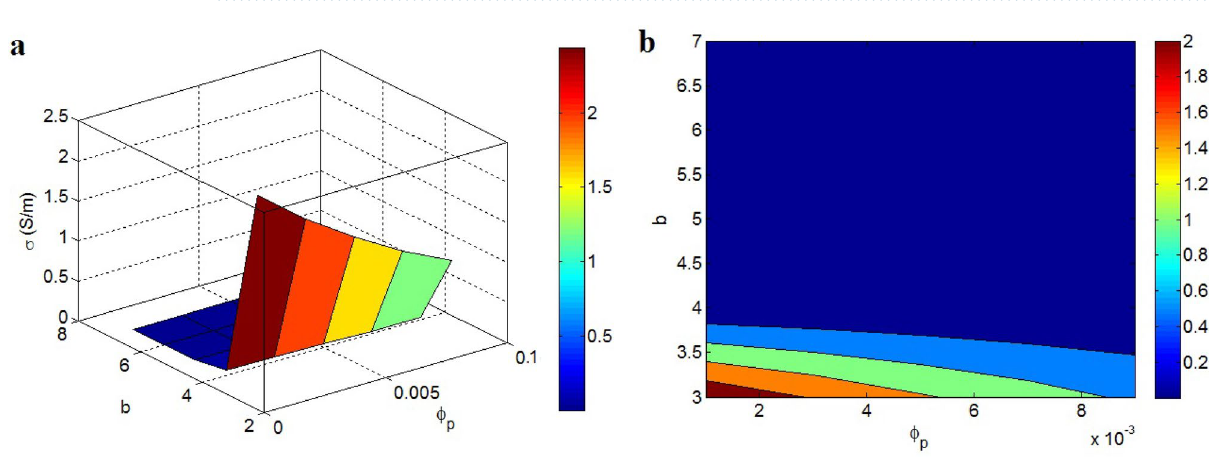
Figure 5. ( a ) 3D and ( b ) 2D schemes for the impacts of “ ϕ f ” and “σ f ” on the conductivity (D = 2 μm, t = 2 nm, t